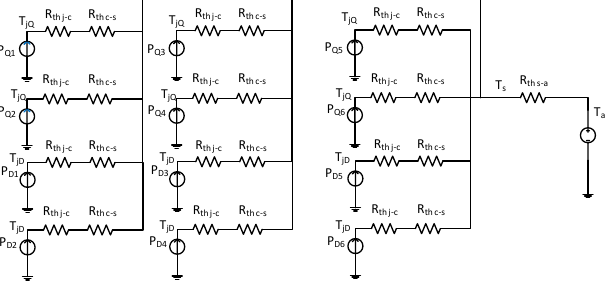
Figure 4. Equivalent thermal model for dissipation of the heat generated by the rectifier switches.